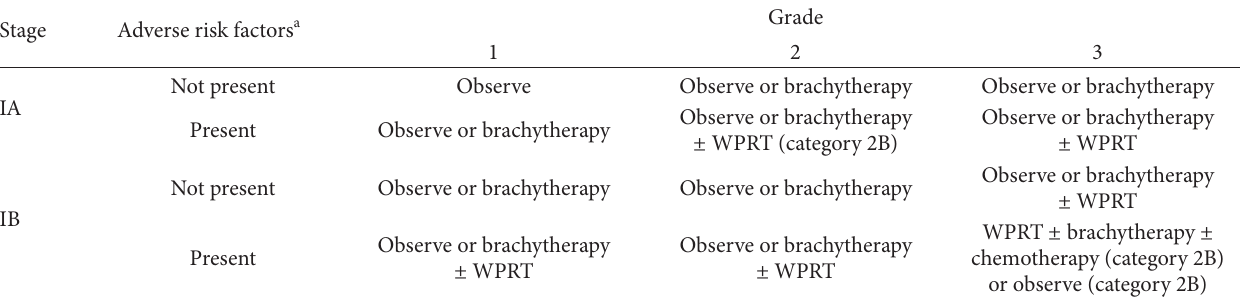
Table 7: NCCN guidelines for adjuvant treatment of early-stage endometrial cancer.